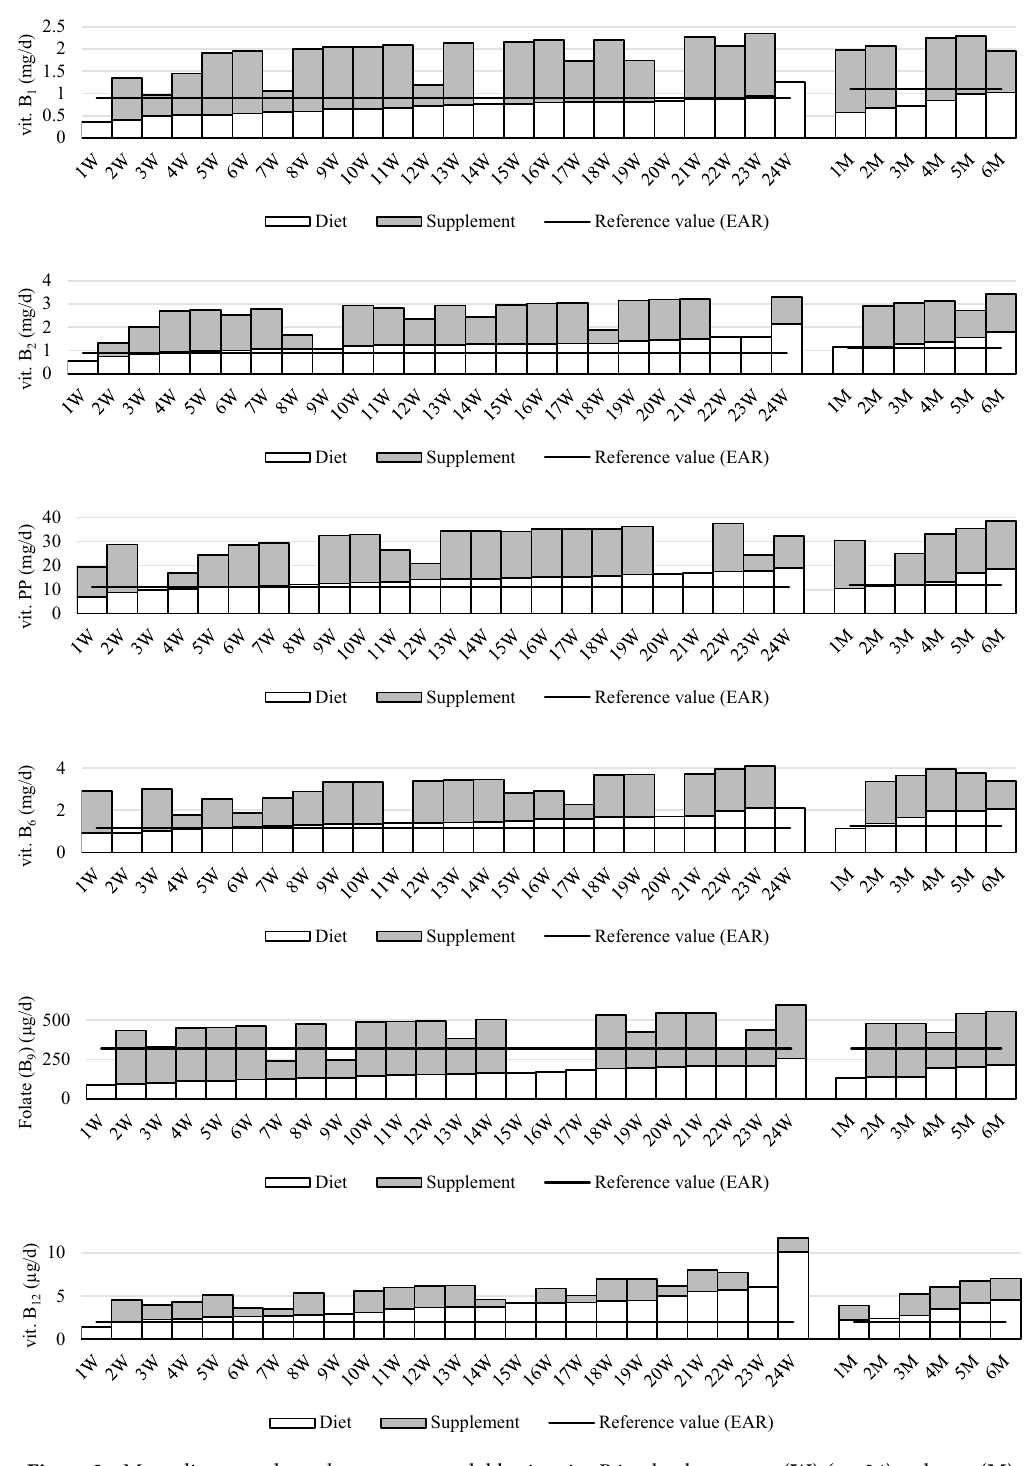
Figure 2. Mean dietary and supplement water-soluble vitamins B intakes by women ( W ) (n = 24) and men ( M ) (n = 6) tested at 3, 6 and 9 months after bariatric surgery (SG) (all data as µg or